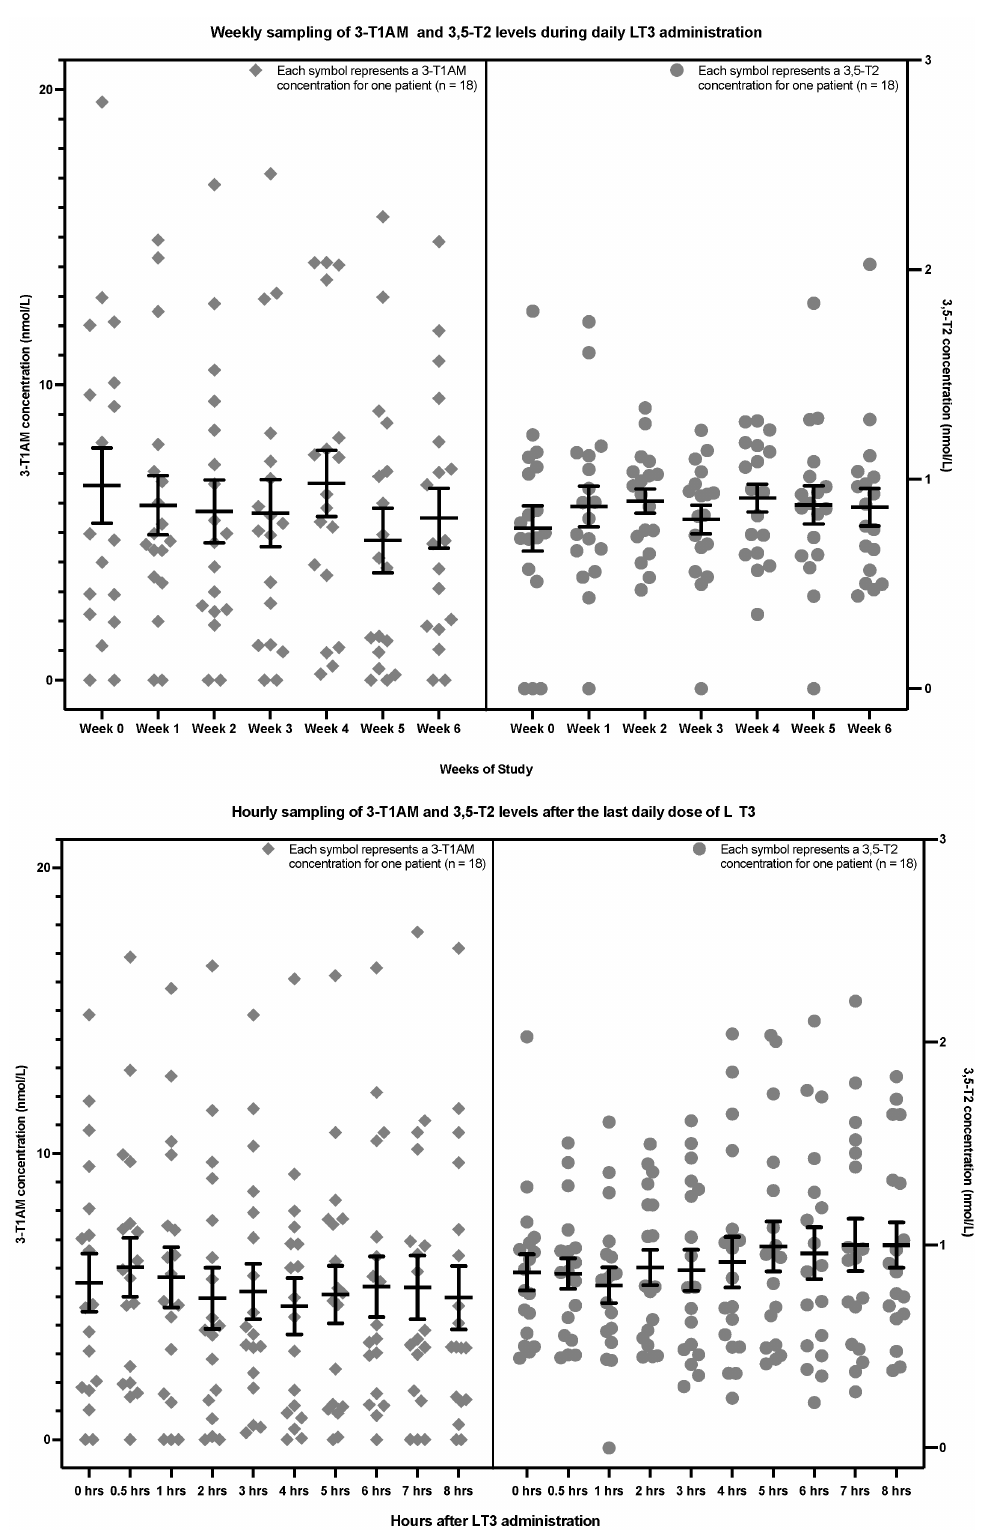
Figure 4. Weekly 3,5-T2 and 3-T1AM concentrations at the time of trough T3 concentrations (upper section) and hourly 3,5-T2 and 3-T1AM concentrations after the final LT3 dose of the study (lower section) in 18 patients with hypothyroidism (The lower limit of detection is 0.2 nmol/L for 3,5-T2 and approximately 5 nmol/L for 3-T1AM. 3,5-T2: 3,5-diiodothyronine, 3-T1AM: 3-iodothyronamine, LT3: